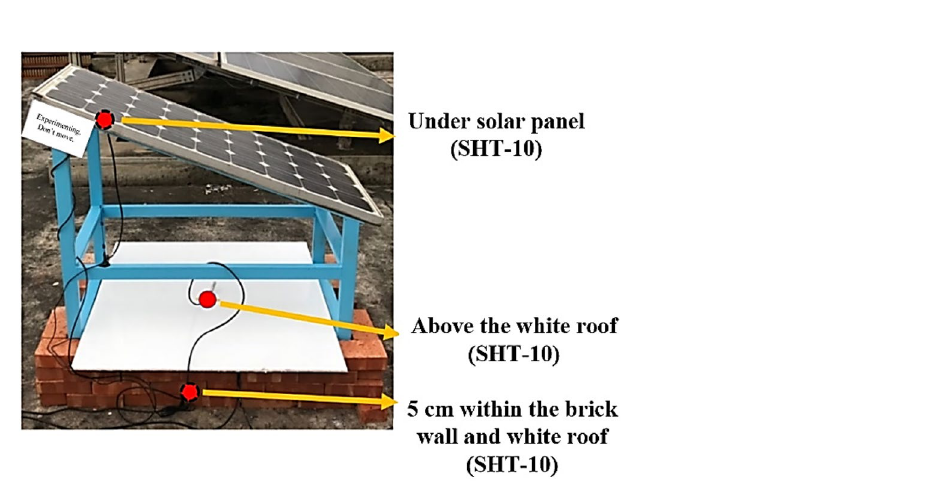
Figure 3. Locations of sensors on the